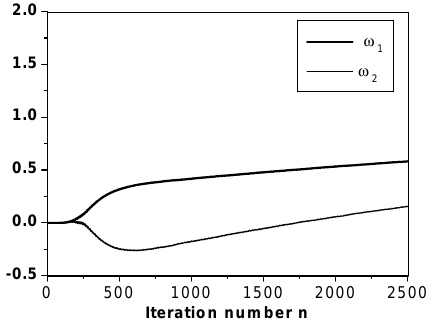
Fig. 21. Evolution of the normalized filter coefficients ( LMS ), case ( C 5 ).